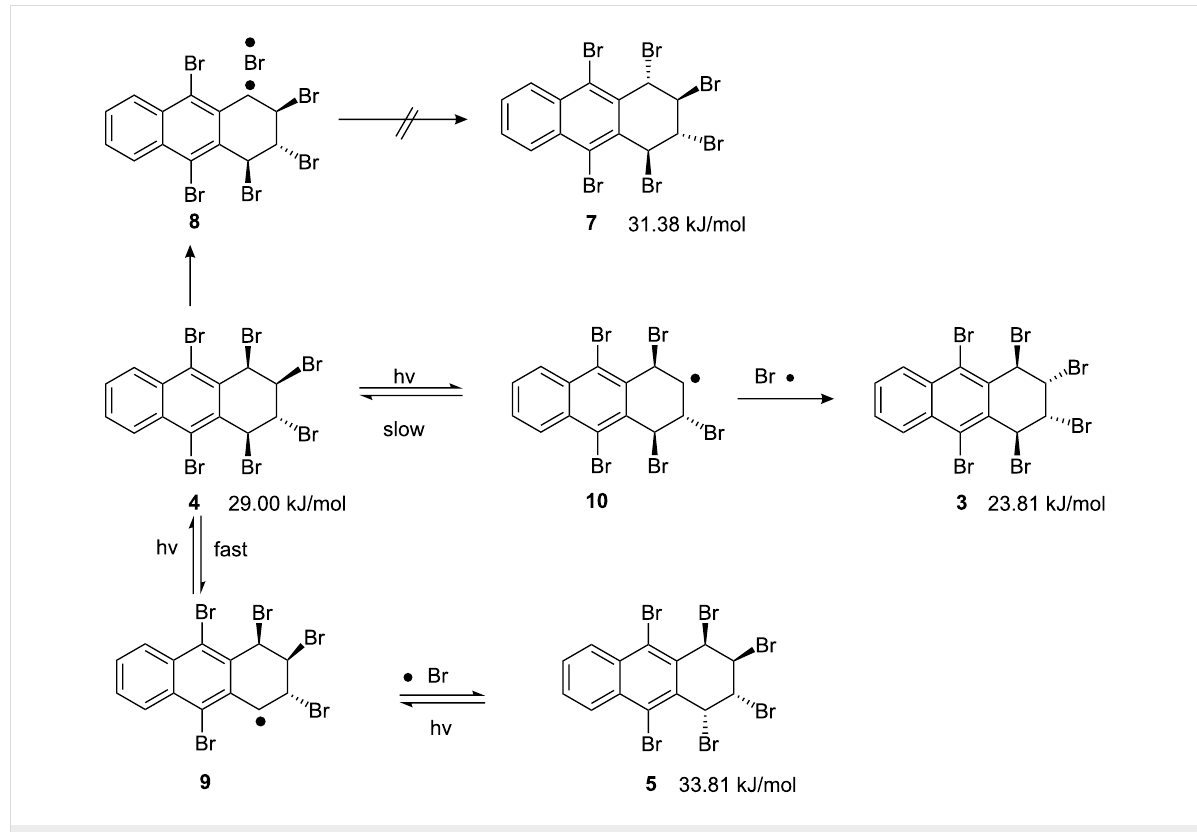
Scheme 2: Configuration isomerization mechanism of the hexabromides.